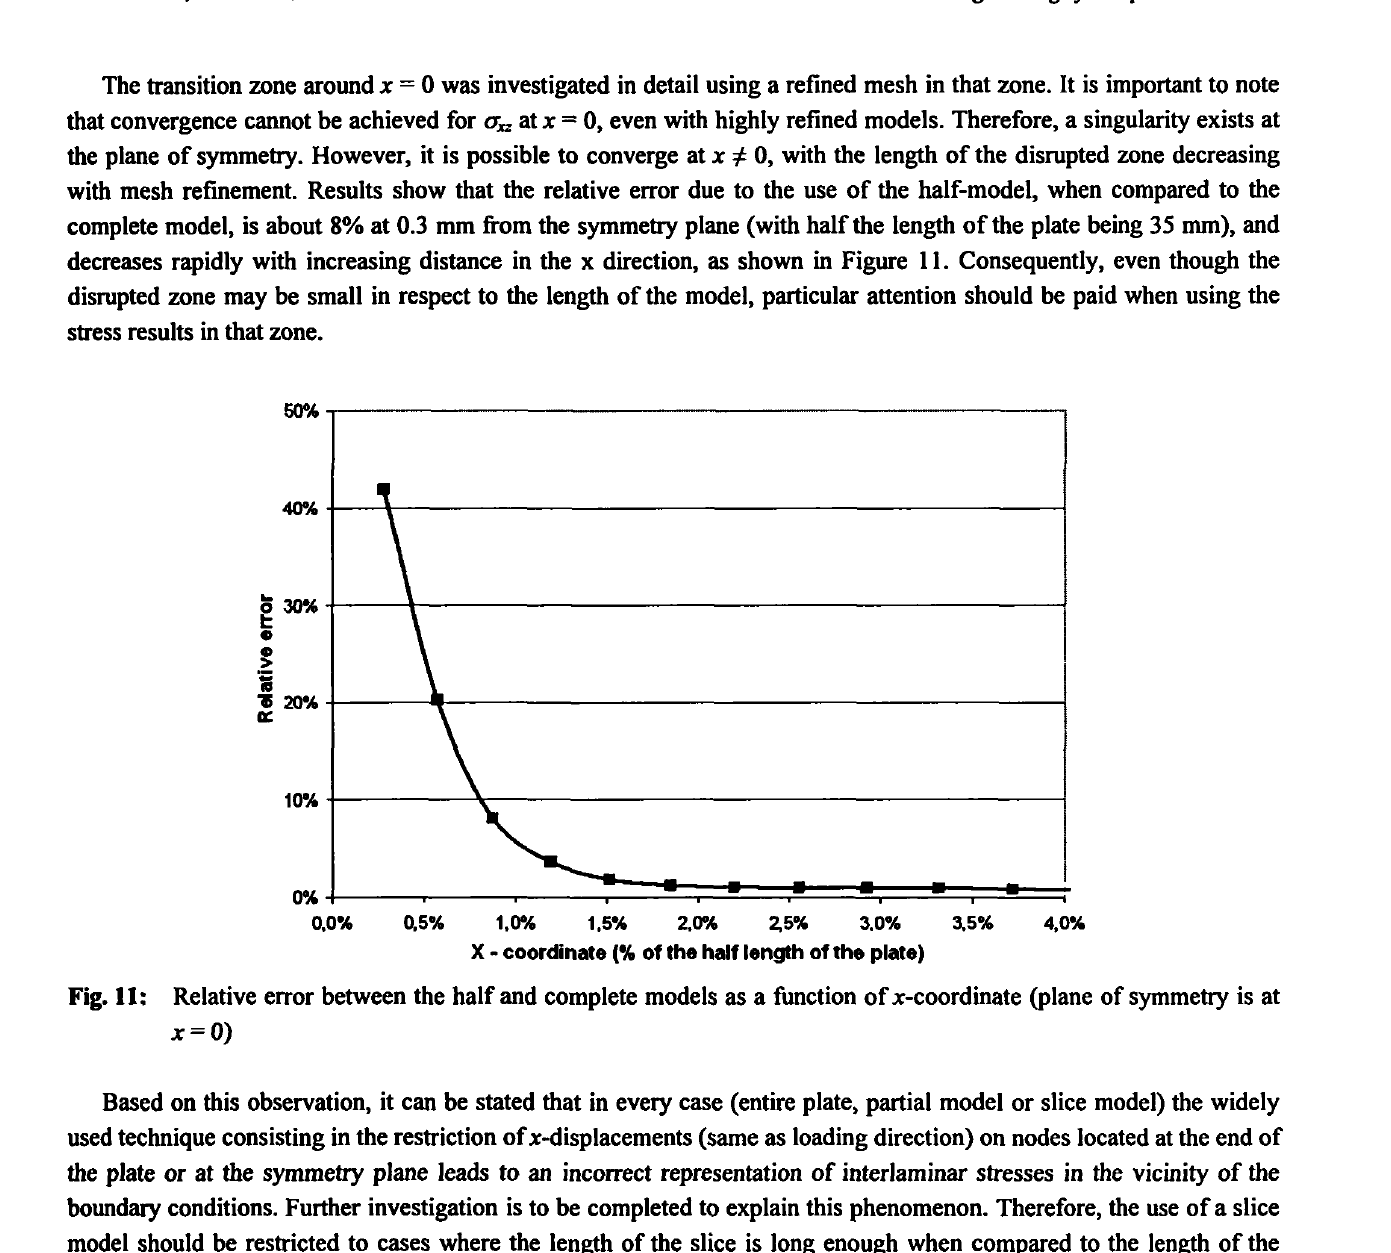
Fig. 11: Relative error between the half and complete models as a function ofx-coordinate (plane of symmetry is at